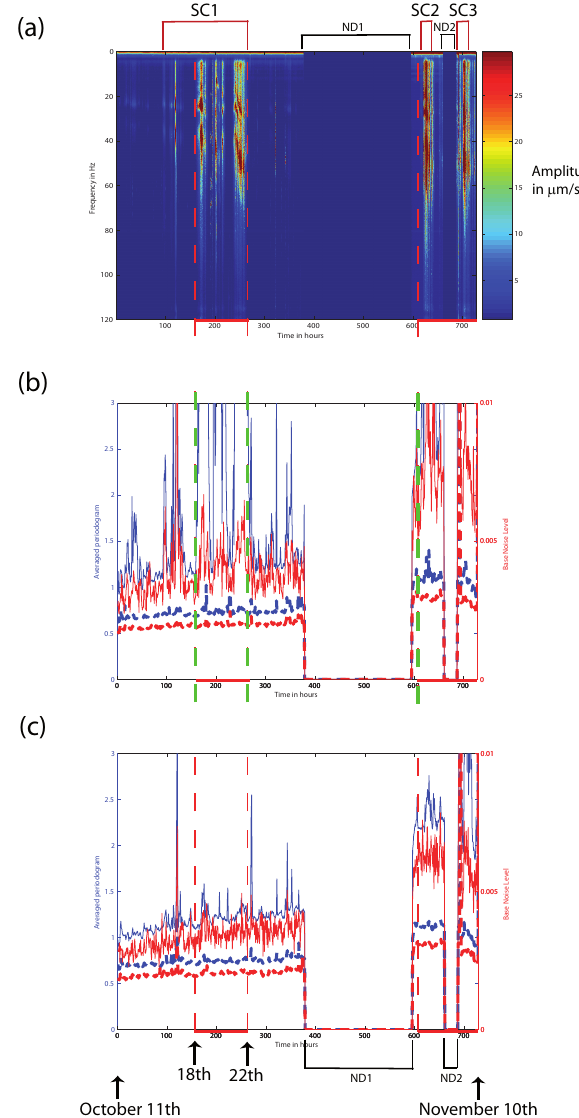
Fig. 3. (a) Spectrogram built from the juxtaposition of the pe- riodograms computed (see text for details) from 11 October to 10 November for the S2 seismometer records, stable massif. (b) and (c) : averaged smoothed periodograms (blue lines) and base noise level (red lines) as a function of time from 11 October to 10 Novem- ber, for two frequency bands: 4–10Hz (solid line) and 120–500Hz (dashed line): (b) stable massif, S2 seismometer, (c) unstable rock slice, S3 seismometer. ND: no data; SC: seismic crisis. Red vertical dashed and horizontal thick lines represent the time periods during which average temperature drops, seismicity and displacement in- crease. Seismic crises induce high amplitudes in the